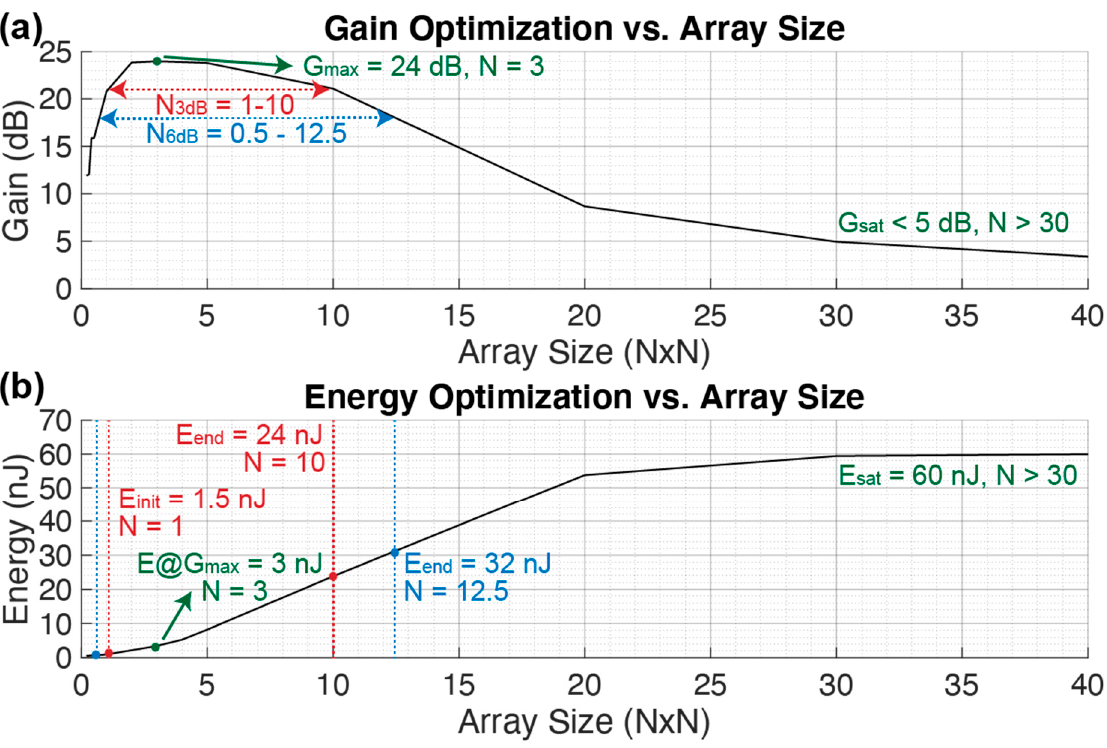
Figure 7. Gain ( a ) and energy ( b ) optimization over a sweep on the array size NxN. The remaining values are maintained constant as in Table